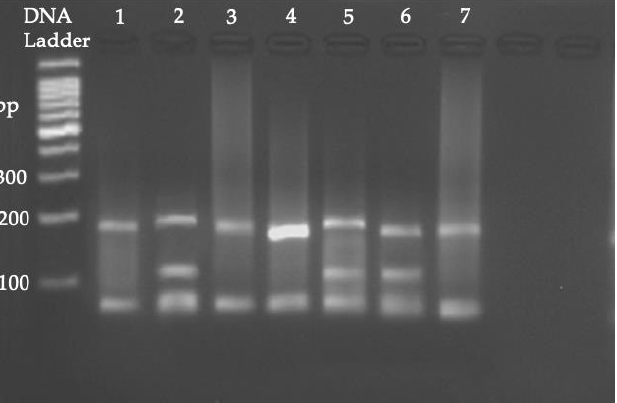
Figure 2. RFLP analysis of a 384 bp fragment of the β-giardin gene ( G. duodenalis ). Lanes 2, 5, and 6 correspond to the AI assemblage (190, 100 and 70 bp) and lanes 1, 3, 4, and 7 correspond to the AII assemblage (210 and 70 bp).